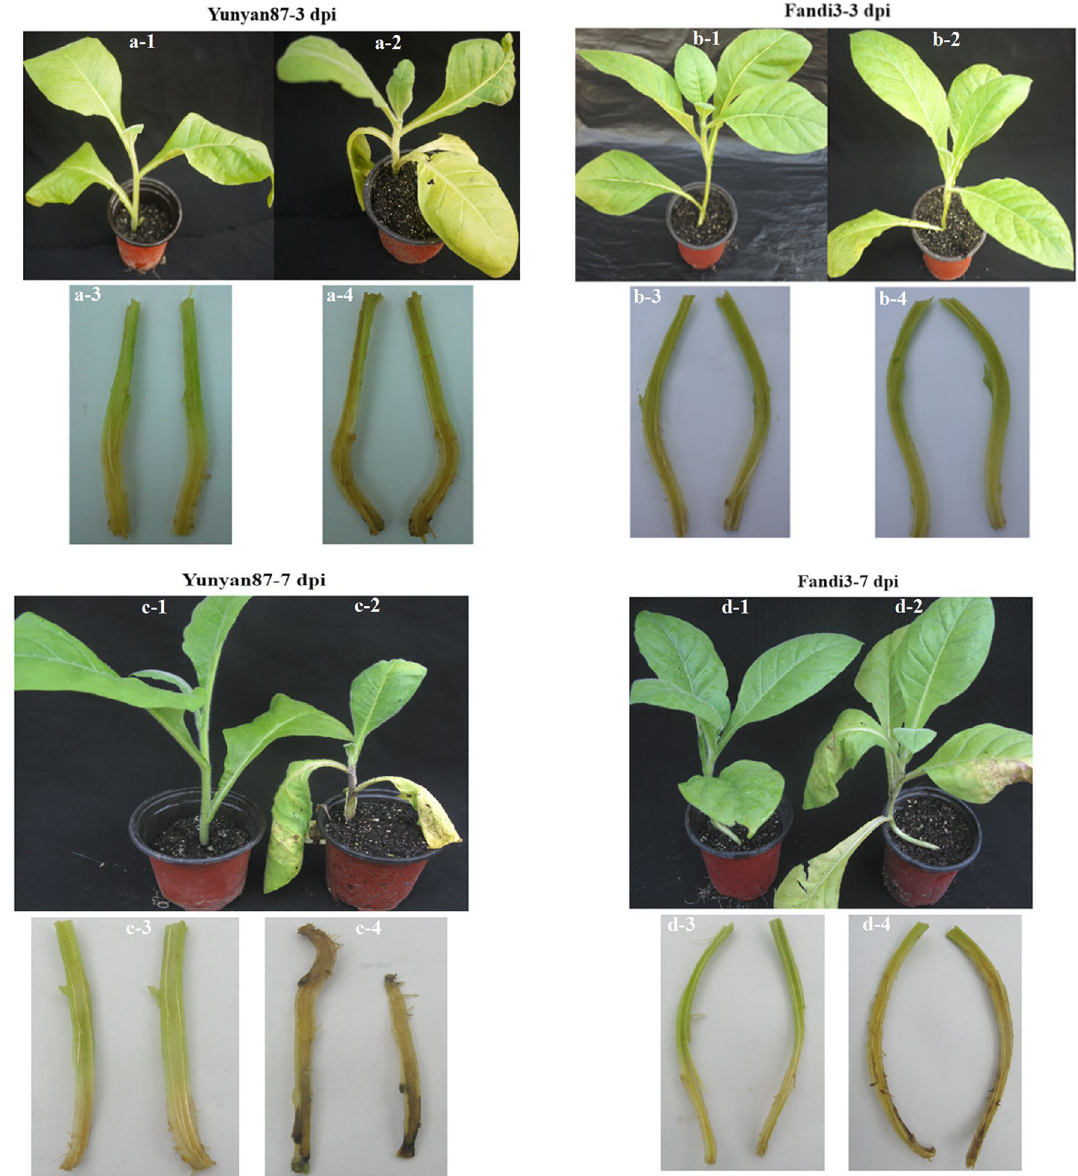
Figure 1. The disease symptoms of the resistant (Fandi3) and susceptible (Yunyan87) cultivars induced by Ralstonia solanacearum infection. Mock-inoculated seedling ( a-1 ), R. solanacearum- inoculated seedling ( a-2 ), mock-inoculated opened-stem ( a-3 ), and R. solanacearum- inoculated opened-stem ( a-4 ) of Yunyan87 at 3 dpi. Mock-inoculated seedling ( b-1 ), R. solanacearum- inoculated seedling ( b-2 ), mock-inoculated opened-stem ( b-3 ), and R. solanacearum- inoculated opened-stem ( b-4 ) of Fandi3 at 3 dpi. Mock-inoculated seedling ( c-1 ), R. solanacearum- inoculated seedling ( c-2 ), mock-inoculated opened-stem ( c-3 ), and R. solanacearum- inoculated opened-stem ( c-4 ) of Yunyan87 at 7 dpi. Mock-inoculated seedling ( d-1 ), R. solanacearum- inoculated seedling ( d-2 ), mock-inoculated opened-stem ( d-3 ), and R. solanacearum- inoculated opened-stem ( d-4 ) of Fandi3 at 7